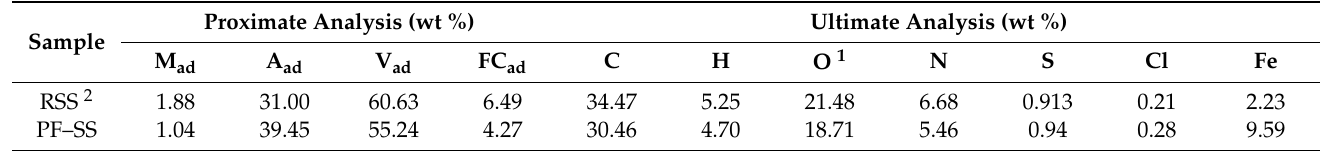
Table 1. Proximate and ultimate analyses of the sludge